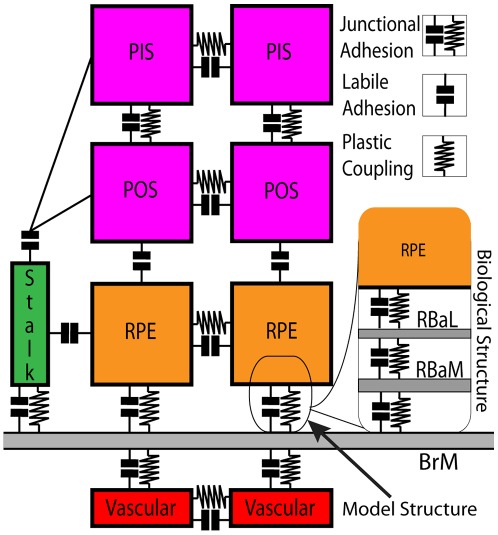
Adhesive interaction processes in the model retina.Our model includes two types of cell-cell and cell-BrM adhesion: 1) labile adhesion and 2) junctional adhesion. Modeled labile adhesion represents cell-cell or cell-ECM labile adhesion in the absence of strong junctional structures (e.g., RPE-POS adhesion). Junctional adhesion combines labile adhesion at cell boundaries with plastic coupling (e.g., between neighboring cells or between BrM and cells). Plastic coupling simulates cytoskeletally-coupled junctional structures as breakable springs (see the Methods section in supplementary Text S3) that mechanically connect neighboring cells and also connect cells to BrM. Junctional adhesion represents biological epithelial or endothelial junctional adhesion or cell-ECM focal adhesion. In the model, a single junctional adhesion between RPE cells and BrM represents the complex biological adhesion between RPE cells and their basal laminae (RBaL), adhesion between the basal laminae and their basement membrane (RBaM) and adhesion between RBaM and BrM (inset). Modeled adhesion processes are: EC-EC and EC-BrM junctional adhesion; EC-RPE, EC-POS and EC-PIS labile adhesion; RPE-RPE and RPE-BrM junctional adhesion; RPE-PIS and RPE-POS labile adhesion; PIS-PIS, PIS-POS and POS-POS junctional adhesion. Key: BrM: Bruch's membrane, RPE: retinal pigment epithelium, RBaM: basement membrane of the RPE, RBaL: basal lamina of the RPE, POS: photoreceptor outer segment, PIS: photoreceptor inner segment.